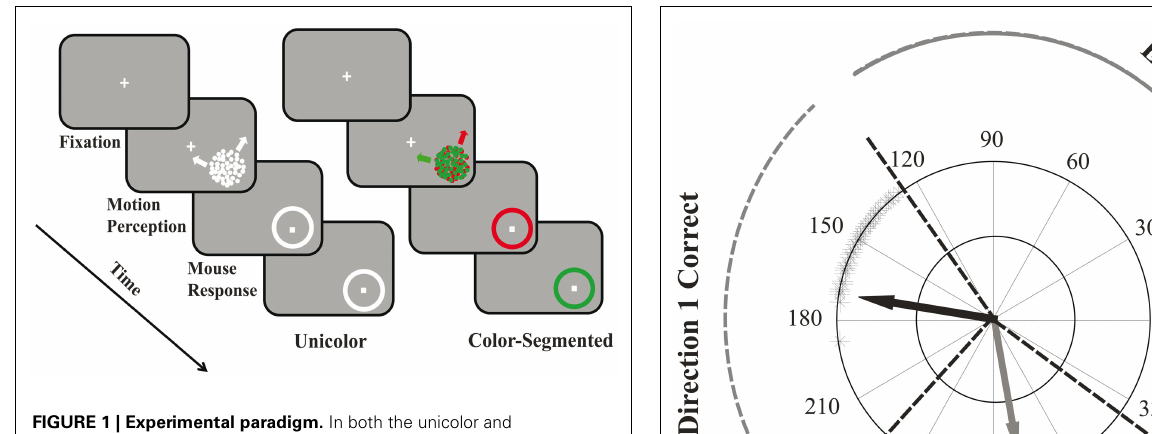
FIGURE 1 | Experimental paradigm. In both the unicolor and color-segmented conditions participants initially fixated a central white “ + .” After fixation was maintained for 200ms an aperture containing two superimposed, coherently moving random dot kinetograms, appeared in the lower right quadrant. In Experiment 1, stimulus duration was set at 1000ms while in Experiment 2, stimulus duration was varied. Participants were to remain fixated during stimulus presentation. A response circle replaced the surfaces, and participants were then free to move their eyes. In the unicolor condition participants made two mouse clicks on the same white response circle indicating the perceived directions of motion. In the color-segmented condition, there were two response circles, one appearing after the other (randomly interleaved). Participants clicked once on each to indicate the perceived direction of motion of that colored surface. FIGURE 2 | Response range of an example participant with correct and